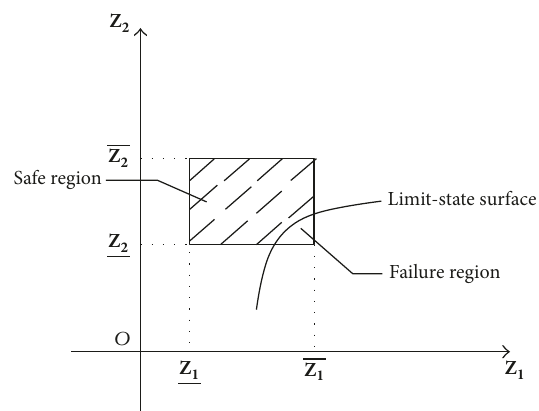
Figure 2: Nonlinear structural performance